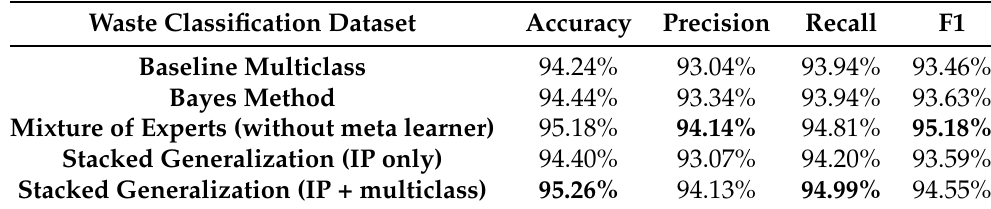
Table 6. Evaluation metrics for the waste classification dataset. The highest accuracy metrics are highlighted using